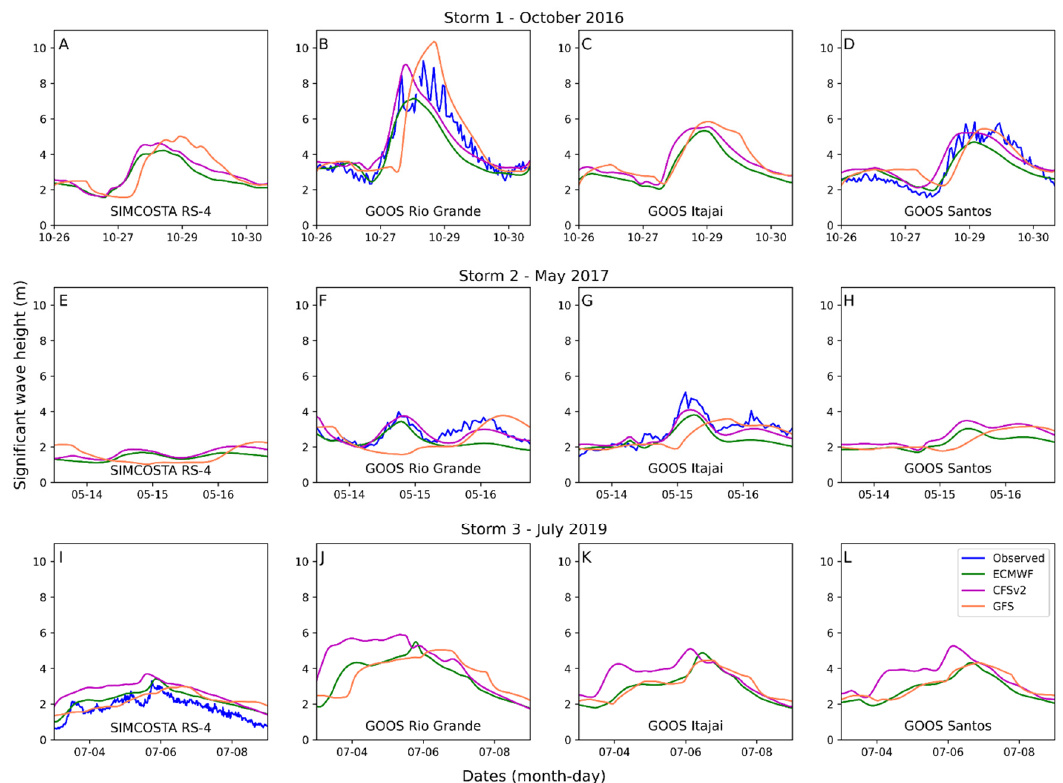
Figure 12. ( A – I ) Wind-generated waves time series at four different buoys. Table 4. Waves error metrics (RMSE in